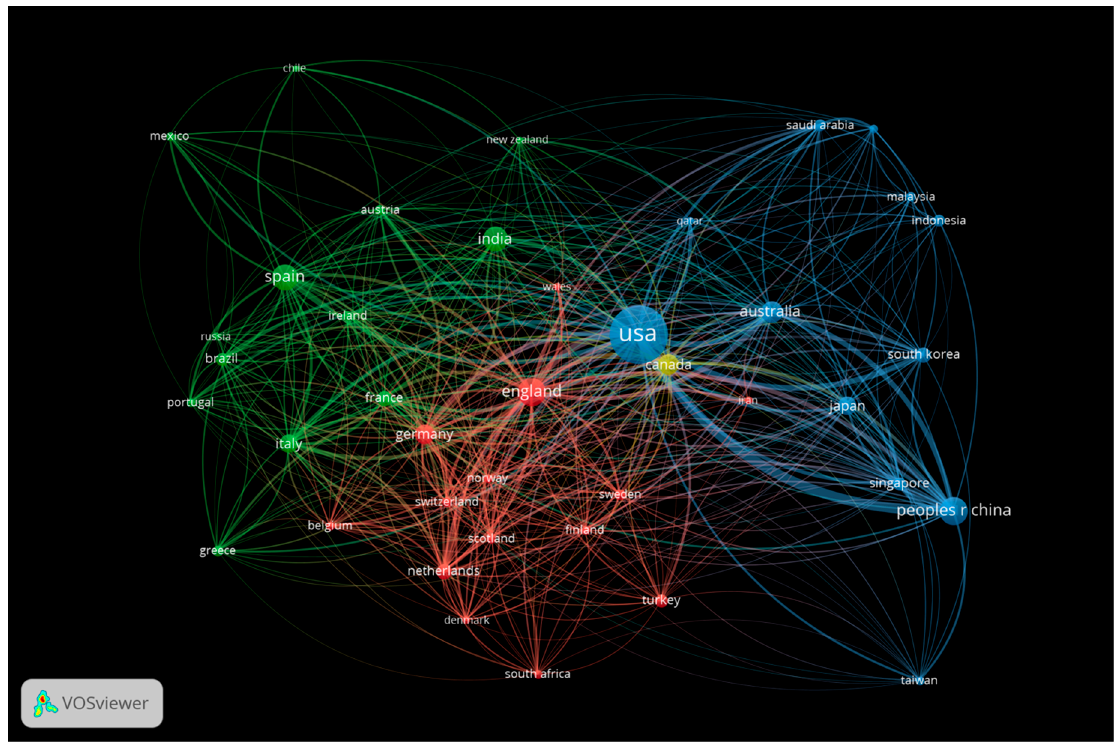
Figure 5. Country collaboration network.